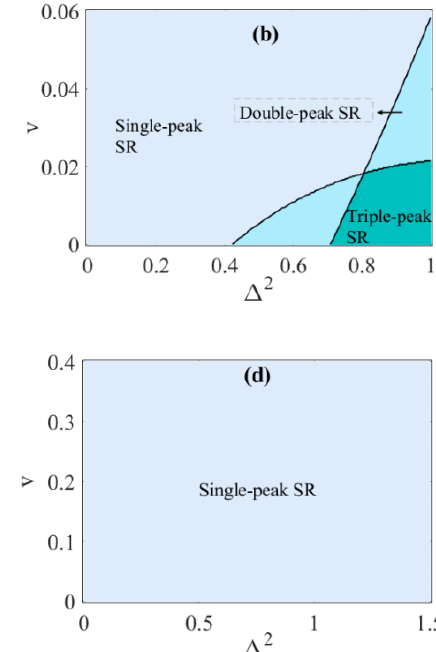
Figure 9. Different GSR patterns relying on combined parameters ( b ) q = 0.2, ( c ) q = 0.25, ( d ) q = 0.9. Single-peak SR happens in the grey area, double-peak SR happens in the cyan area, and triple-peak SR happens in the green area, respectively.